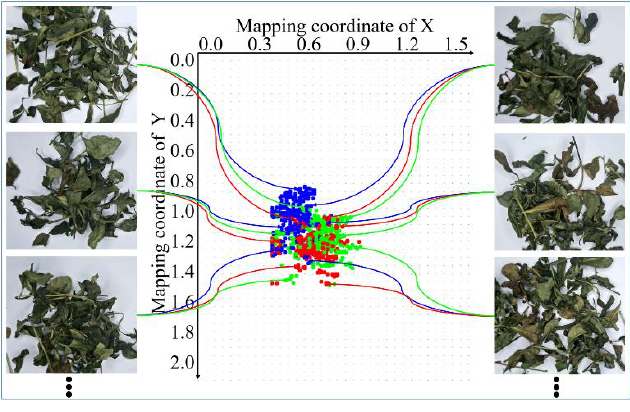
Figure 7. Clustering results of energy at the same fixation time.